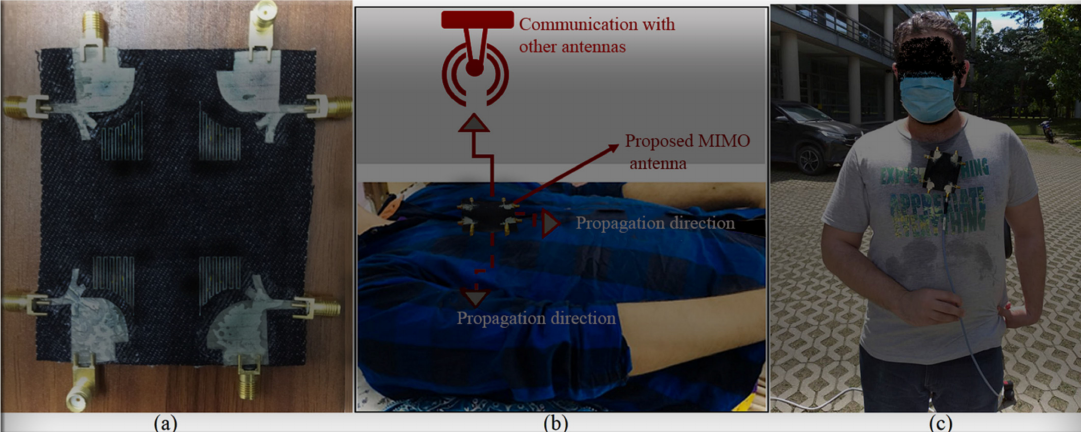
Figure 19. The MIMO antenna on a denim flexible board: ( a ) fabricated, ( b ) measurement setup on chest while laying down, and ( c ) measurement setup on chest standing in free space.